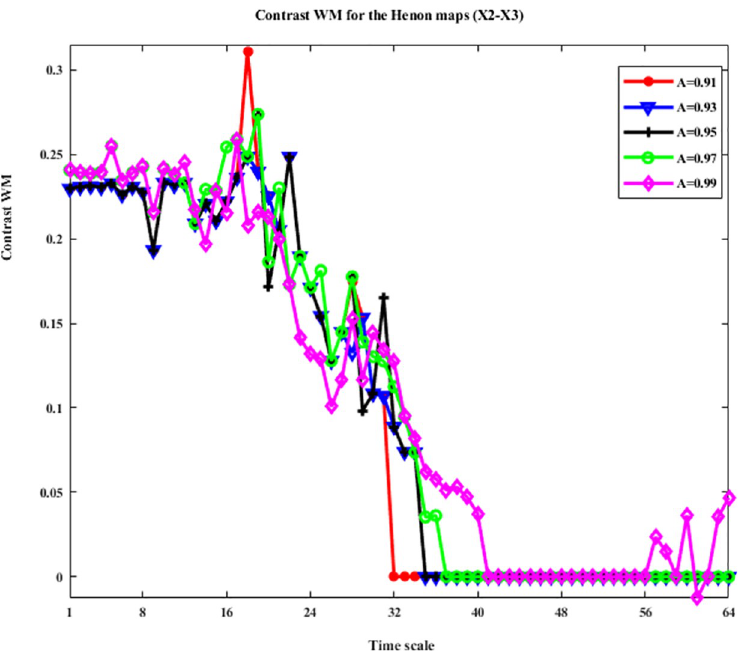
Fig 7. The contrast WM for the four unidirectionally coupled Henon maps with different stopping criteria (X1-X3). This figure shows the contrast WM between X1 and X3: O WM , X 1 ! X 3 ( s i , e ) = WM C , X 1 ! X 3 ( s i , e ) − WM C , X 3 ! X 1 ( s i , e )(i = 1,2, ... 64) with different stopping criteria and time scales. This curves with different colors represent the contrast WM obtained by different stopping criteria.